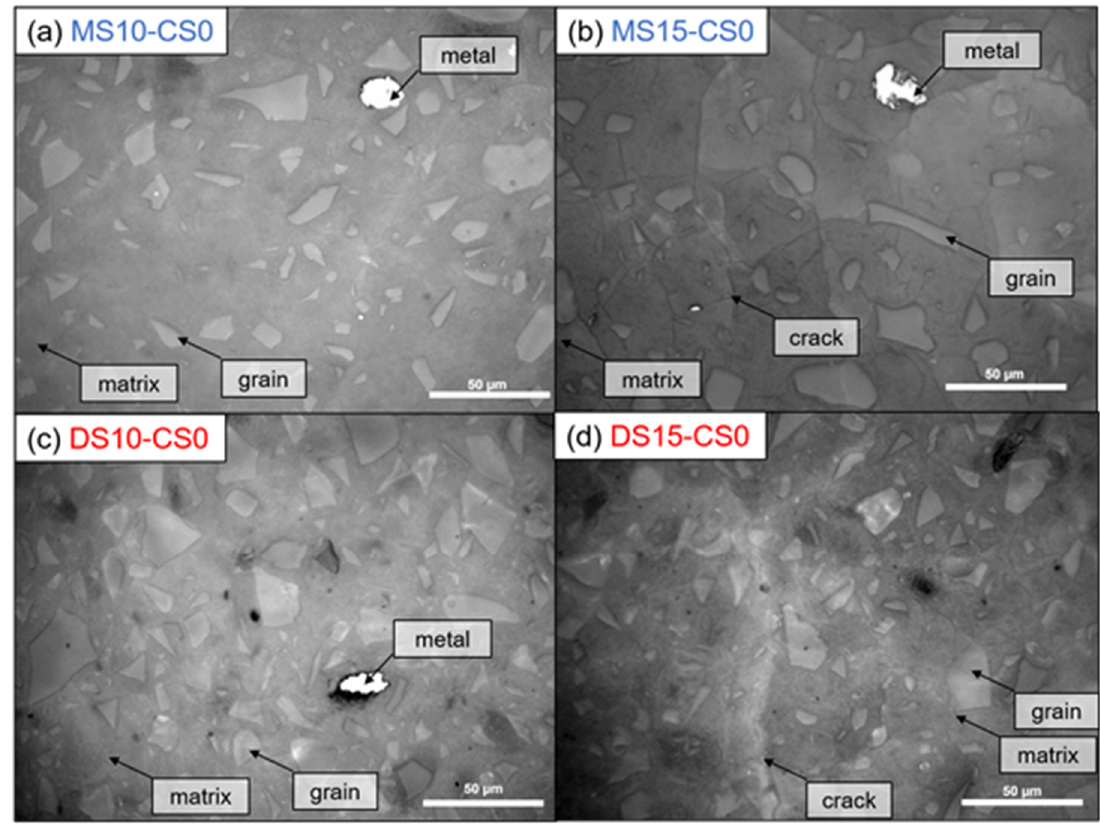
Figure 10. Optical microscopy with incident light. White is Fe-metal, light gray are GGBS grains, darker gray is the matrix, and dark lines are cracks (See Table 2 for mix design).